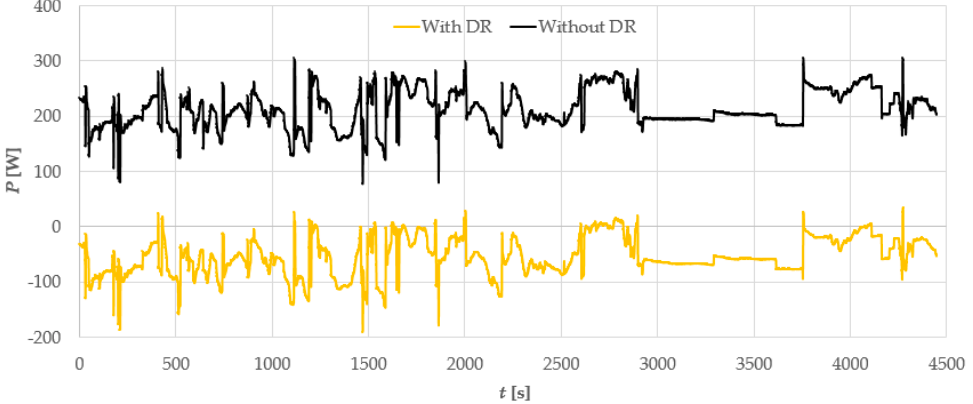
Figure 11. The difference between the energy rates supplied to and consumed in the microgrid, with and without demand response activated.